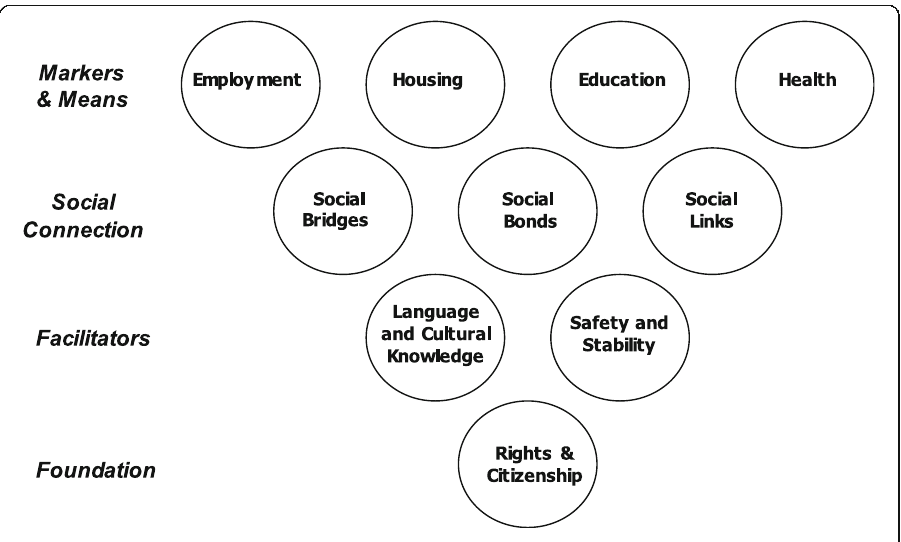
Fig. 3 Ager and Strang ’ s Conceptual Framework (2008). Source: Ager and Strang 2008, p.